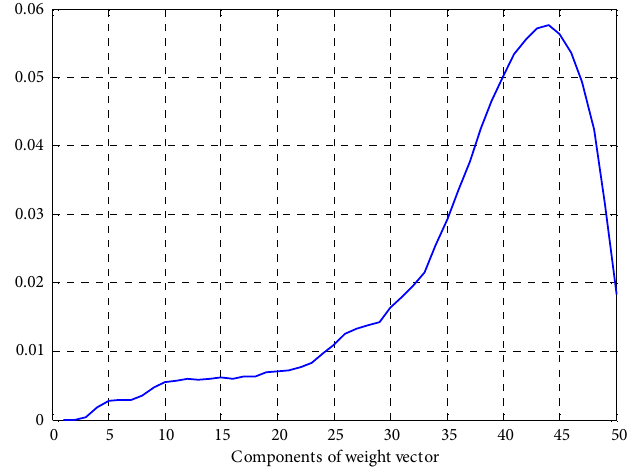
Fig. 4. Weights of the CMA n = 50 method after